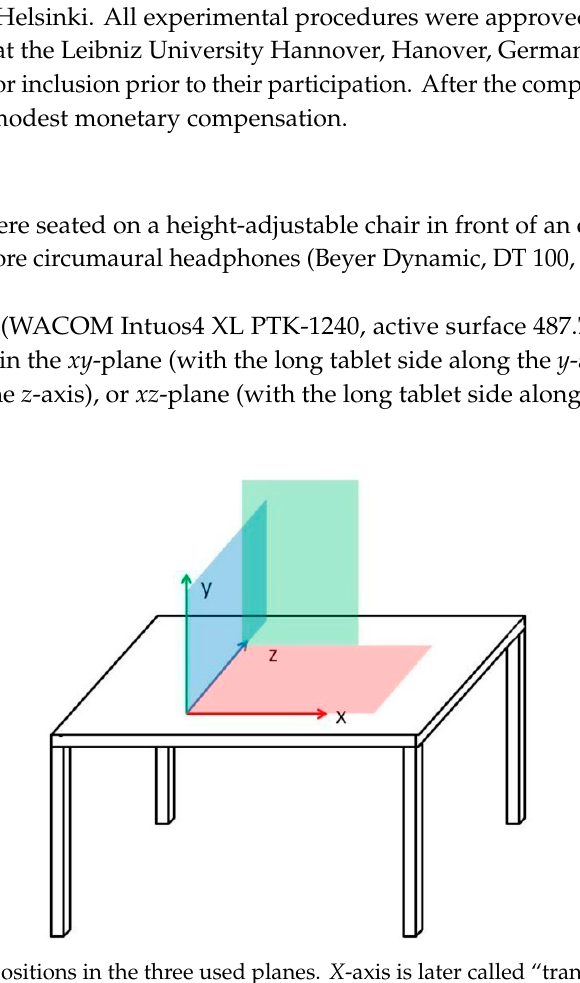
Figure 1. The tablet positions in the three used planes. X -axis is later called “transverse axis”, y -axis is later called “longitudinal axis” and z -axis is later called “sagittal axis”. The subject sits at the front edge of the table, looking in the direction of the z -axis.